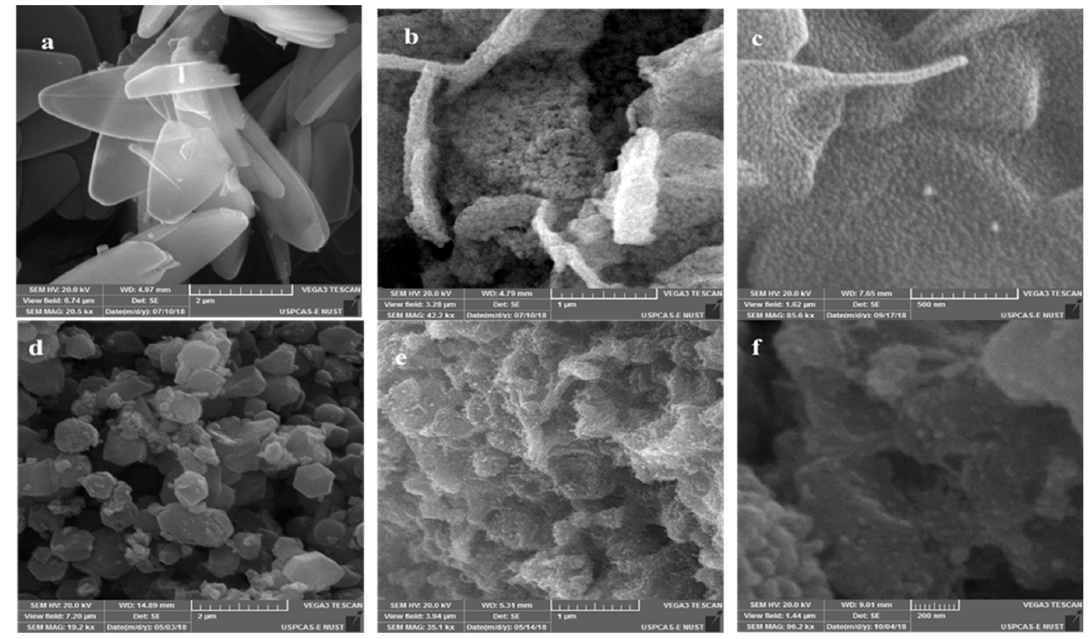
Figure 1. SEM images of ZIF-67 prepared in different solvents: ( a ) ZIF-67 prepared in H 2 O, before pyrolysis, after pyrolysis; ( b ) NPC/CO (H 2 O) at 700 °C; ( c ) NPC/CS (H 2 O); ( d ) ZIF-67 prepared in MeOH; ( e ) NPC/CO (MeOH) at 700 °C; and ( f ) NPC/CS (MeOH).